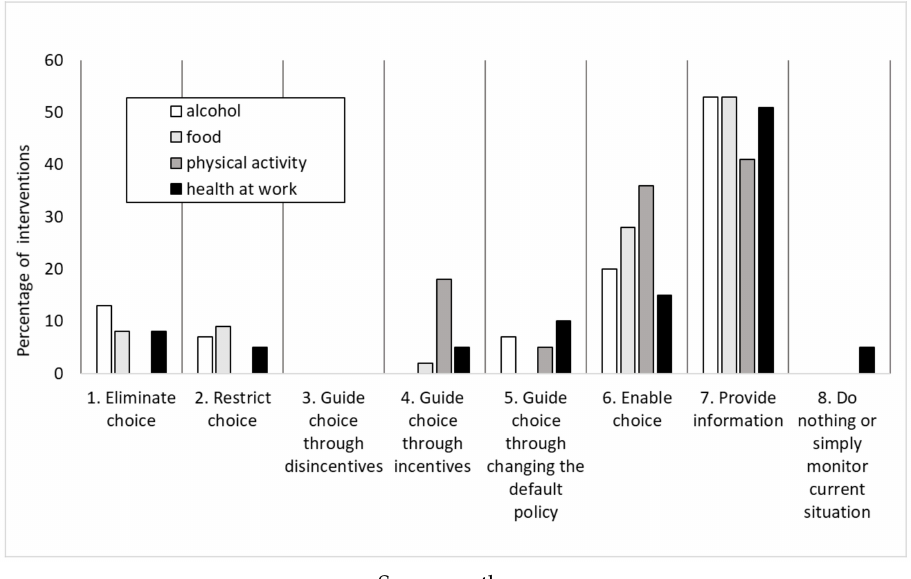
Figure 4. Relative distribution of all RD interventions by